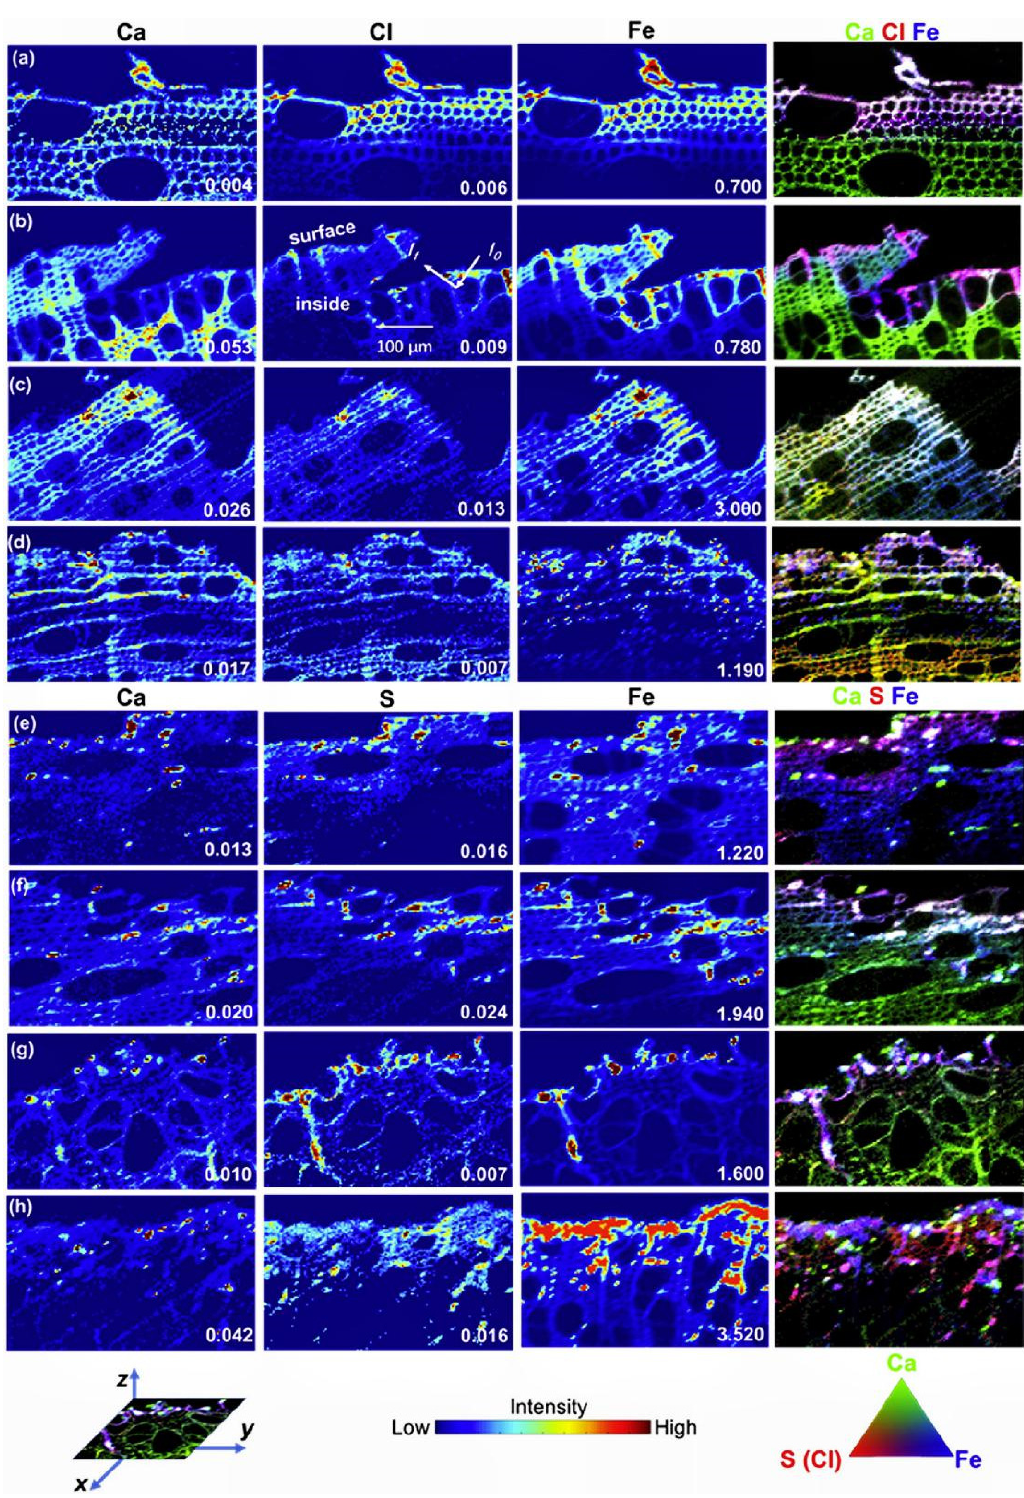
Figure 16. Elemental maps of FeCl 3 BM ( a ), FeCl 3 BC300 ( b ), FeCl 3 BC600 ( c ), FeCl 3 BC900 ( d ), FeSO 4 BM ( e ), FeSO 4 BC300 ( f ), FeSO 4 BC600 ( g ), and FeSO 4 BC900 ( h ) acquired utilizing confocal micro-X-ray fluorescence imaging (CMXRFI). Left passed on to right segment: Ca, Cl (S), Fe, and combined tri-color maps of these elements. The top part is the surface of the particle. The values in the bottom right corner are the maximum normalized intensities of the corresponding element [131]. Reprinted with permission from Yu Feng et al. (2019). Copyright 2019, Elsevier.